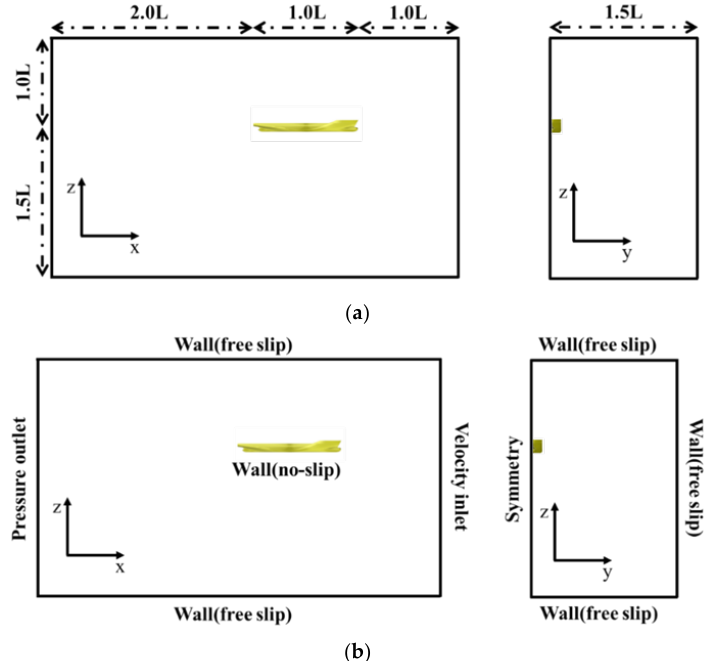
Figure 2. Computational domain and boundary conditions for numerical simulation; ( a ) computational domain and ( b ) boundary condition.